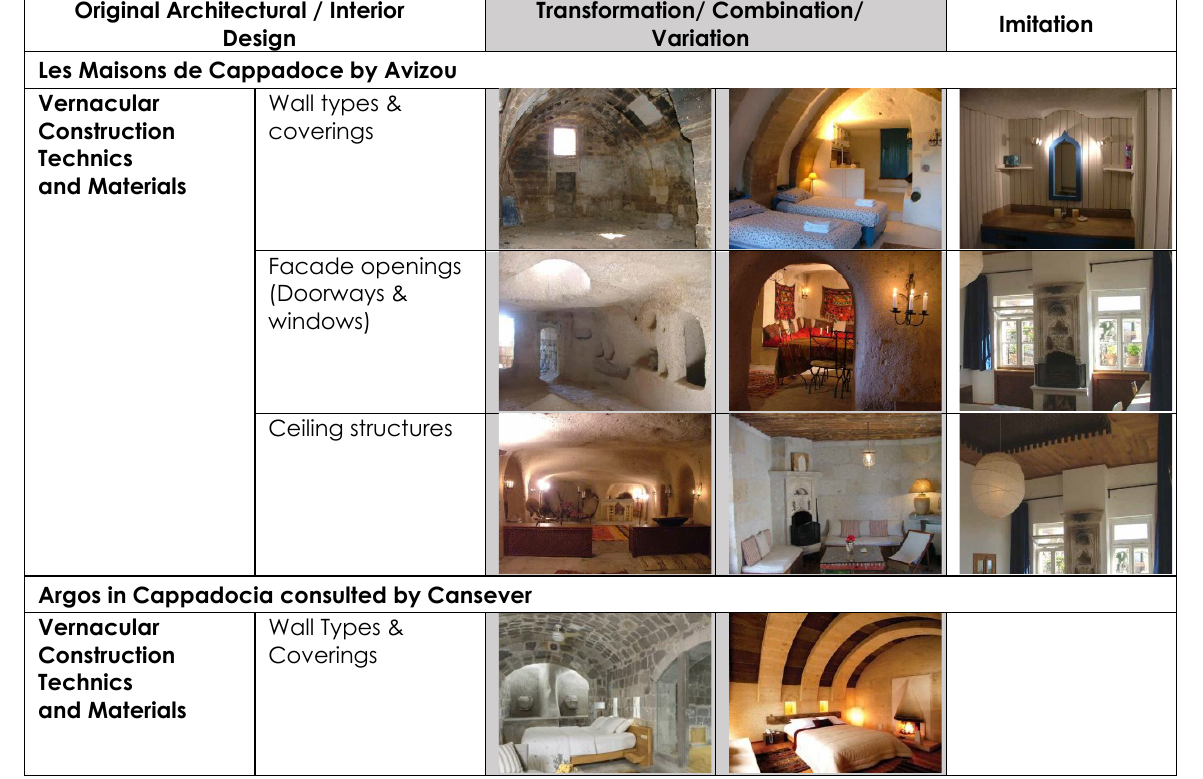
Table 7. Taxonomy of Design Guideline ‘Vernacular Construction Technics and Materials’ according to Levels of Novelty. (Argos Yapi 2019; Les Masion Cappadocia., 2019) Original Architectural /